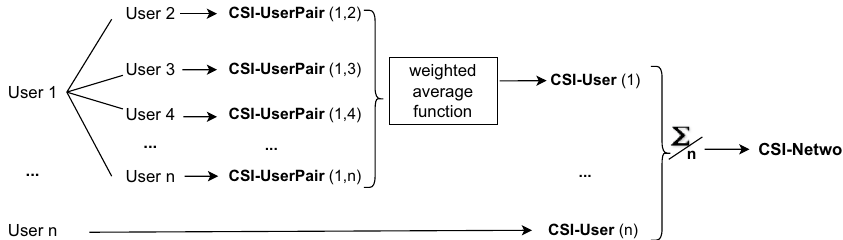
Fig. 1 Computation of combined synchronization index. Flowchart of the computation and aggregation of the hierarchical Combined Synchronized